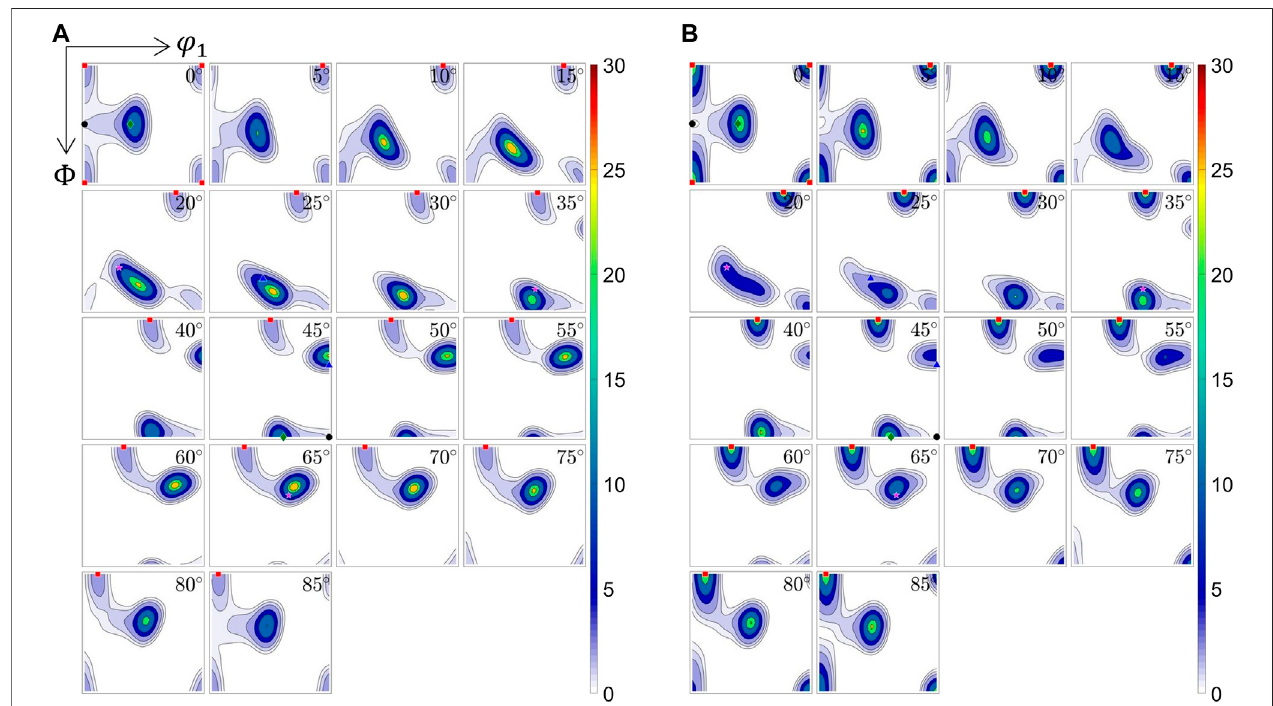
FIGURE1| Theexperimental textureoftheas-extrudedpro fi leintheformofODFforthecenterregion (A) AA6063 extrudedat350 ° Cand (B) AA6082extrudedat 500 ° C.